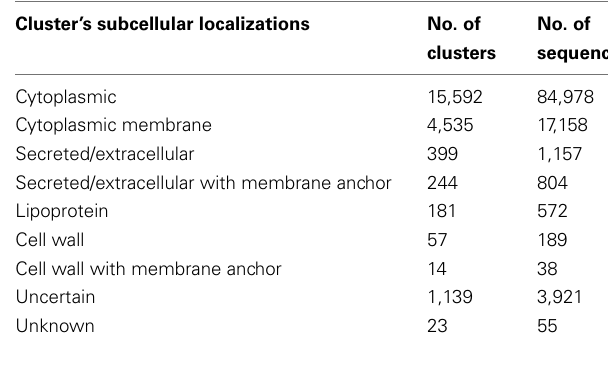
Table 7 | ClubSub-P archaeal SCL prediction